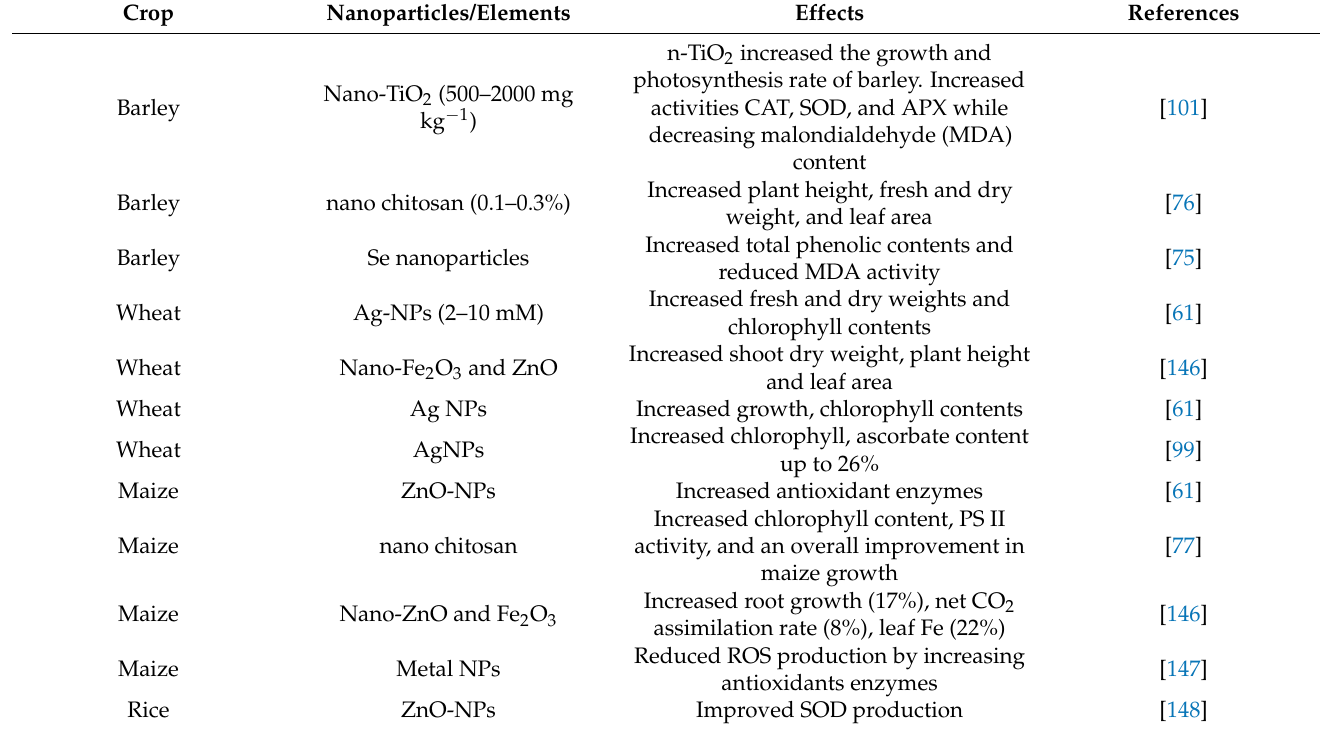
Table 2. Effect of nanoparticles on growth and development under salt-stressed